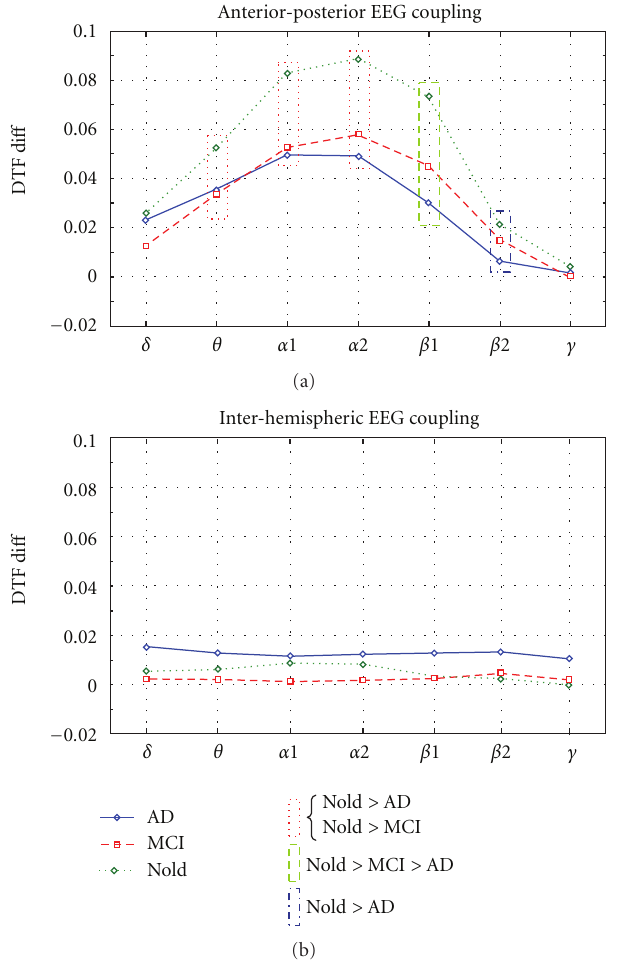
Figure 1: (a) Means of anterior-posterior DTFdi ff values computed in the Nold, amnesic MCI, and AD for all frequency bands of interest ( δ , θ , α 1, α 2, β 1, β 2, γ ) averaging the anterior-posterior DTFdi ff values of the three electrode pairs (F3-P3, Fz-Pz, F4-P4), in order to represent a two-way ANOVA interaction ( F (12,1218) = 3.49; P < . 00001) between the factors group (AD, amnesic MCI, Nold) and Frequency band ( δ , θ , α 1, α 2, β 1, β 2, γ ). (b) Means of inter-hemispheric DTFdi ff values computed in the same subjects and frequency bands of interest. Means were obtained averaging the inter-hemispheric DTFdi ff values of the electrode pairs (F3-F4, C3- C4, P3-P4).